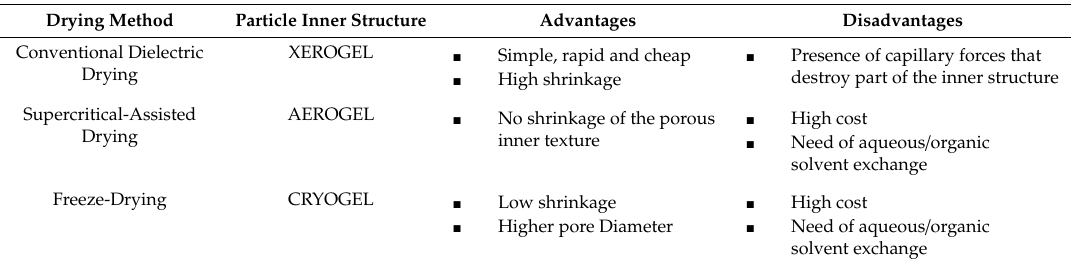
Table 1. Main characteristics of the drying methods for polysaccharide